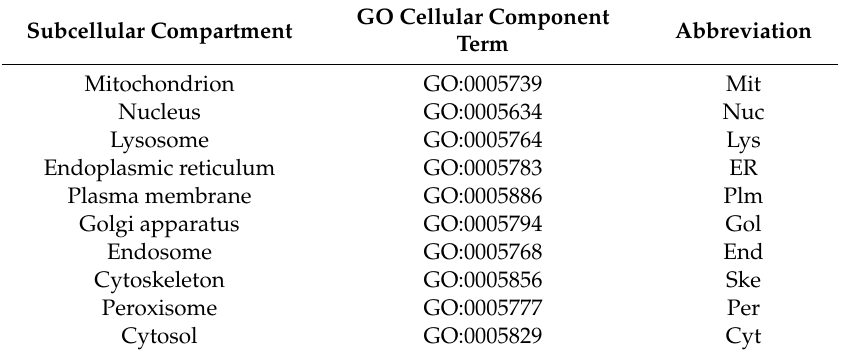
Table 1. Subcellular compartments analyzed and their corresponding gene ontology (GO)